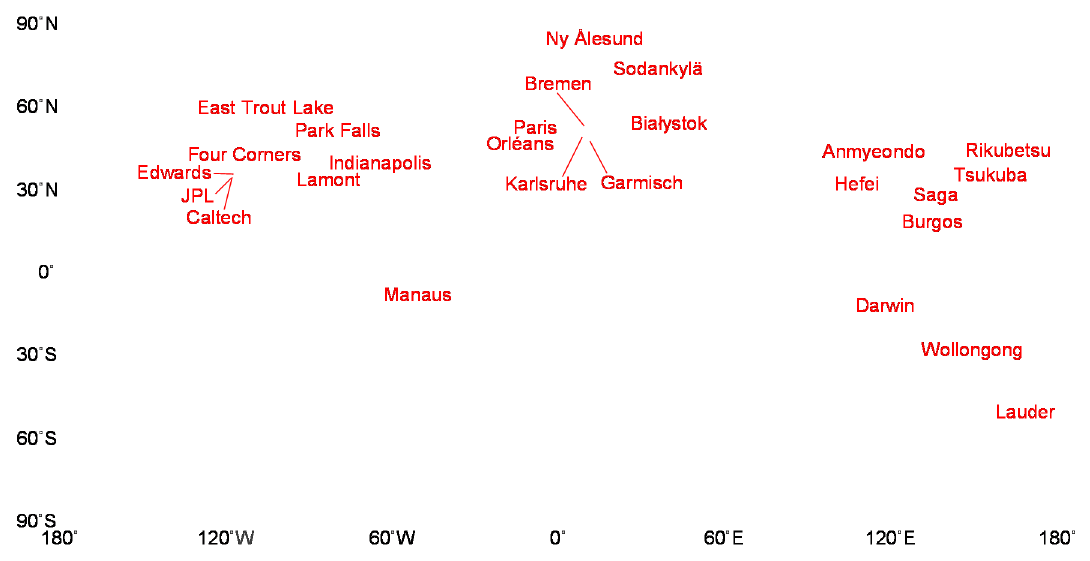
Figure A1. Map of the TCCON sites used.